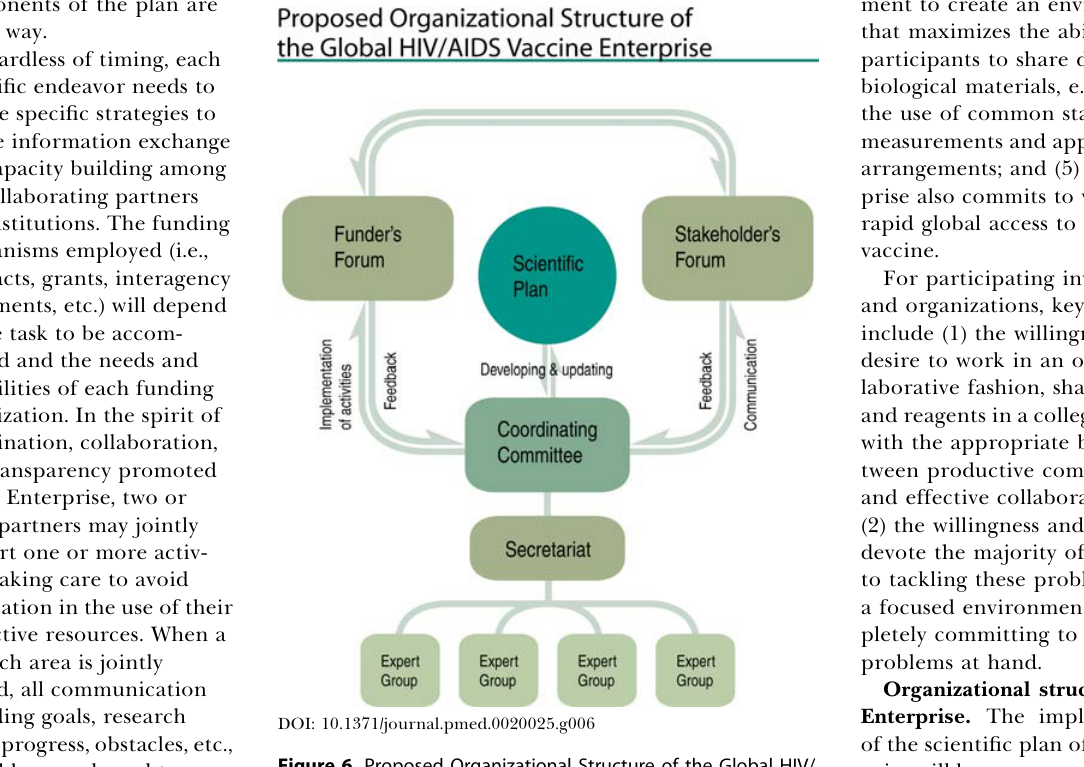
Figure 6. Proposed Organizational Structure of the Global